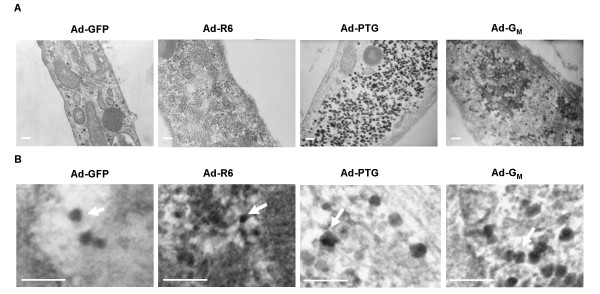
Glycogen particles. Cultured human myotubes were transduced with Ad-GFP, Ad-R6, Ad-PTG or Ad-GM and incubated with 25 mM glucose for 48 h and then fixed and stained for observation of glycogen particles in transmission electronic microscopy. Representative images are shown: (A) image of myotubes obtained at × 40000 magnification, in which glycogen granules appear as dense spheroid particles, and (B) a detail of glycogen granules (arrows). Scale bars = 100 nm.